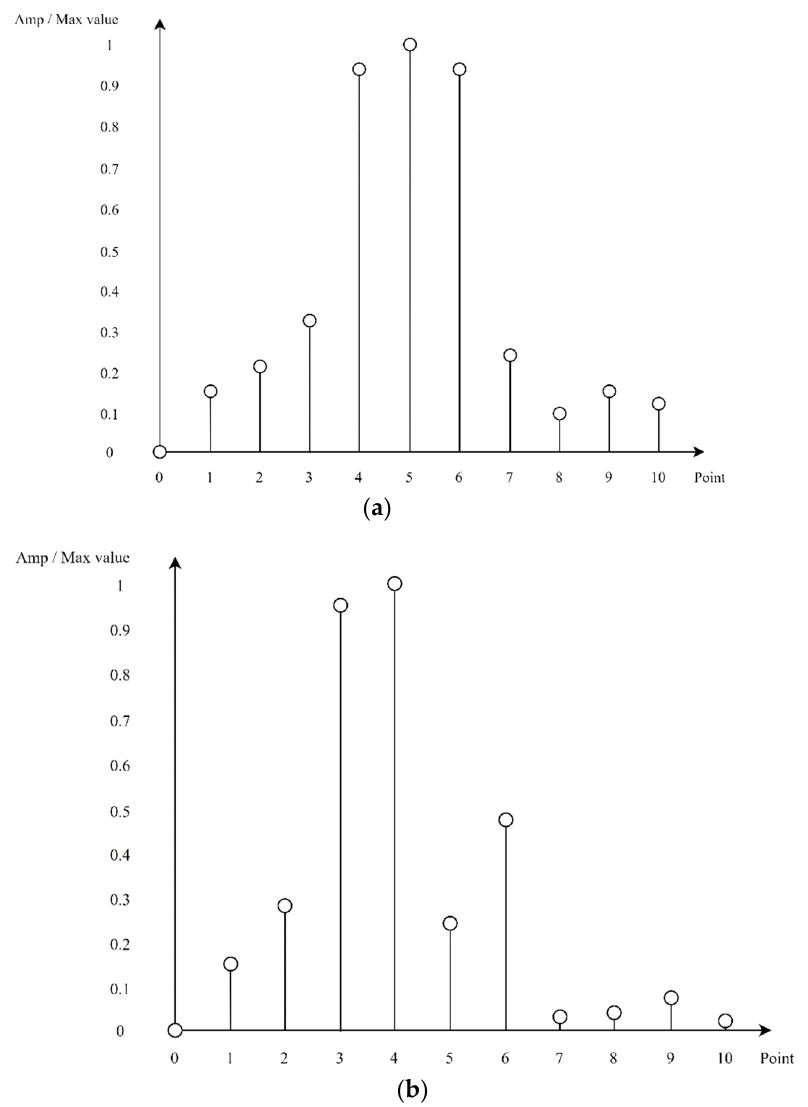
Figure 8. Frequency-domain signals for multiple targets. ( a ) Case of locations of targets are ambiguous; ( b ) Case of positions of the two objects are between 3 and 4 m and between 5 and 6 m.